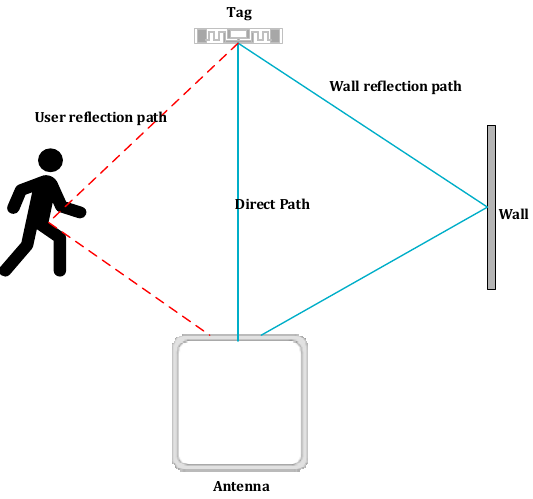
Figure 1. Signal propagation path.